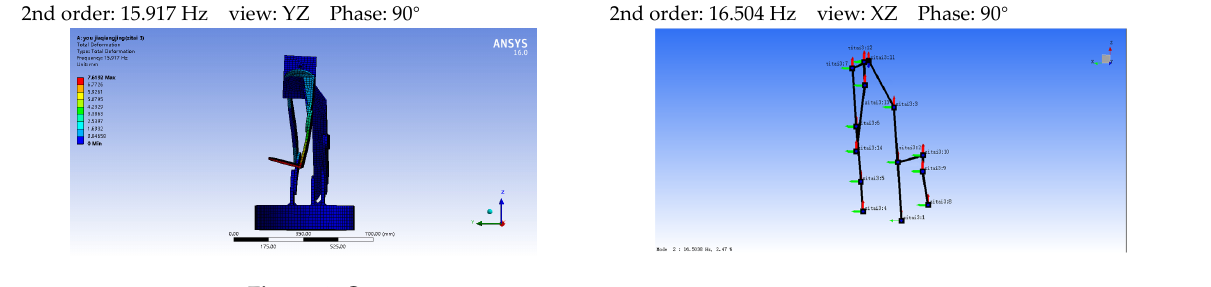
( b ) Figure 4. ( a ) Second-order simulation mode diagram; ( b ) Second-order test mode diagram. 3rd order: 18.162 Hz view: YZ Phase: 120 ° ( b ) Figure 5. ( a ) Third-order simulation mode diagram; ( b ) Third-order test mode diagram.